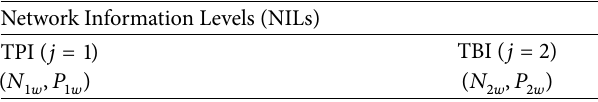
Table 2: The completed information-knowledge matrix of travel